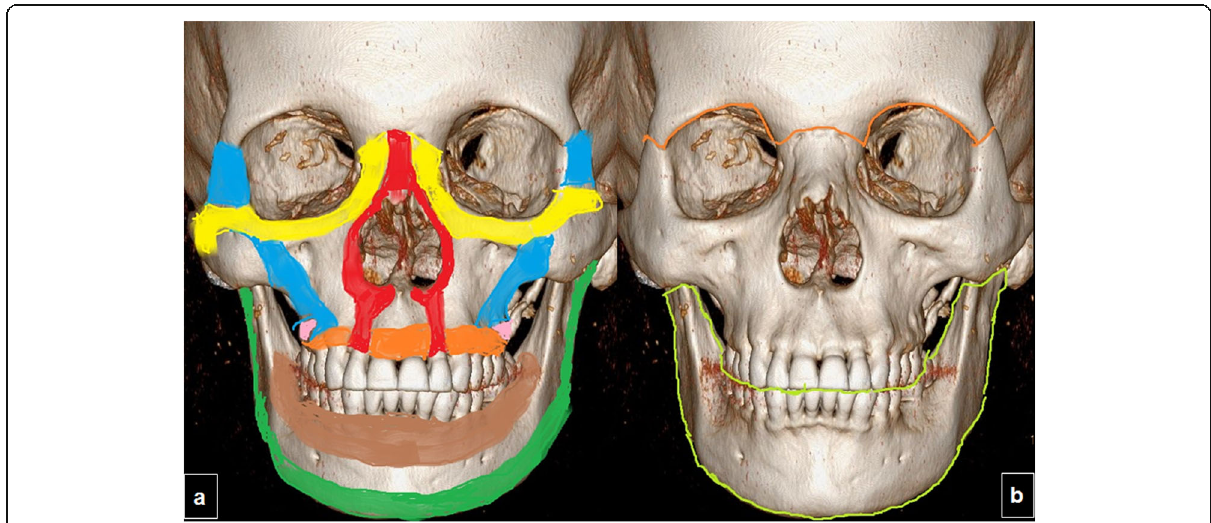
Fig. 1 Facial anatomy. a System of facial struts/buttresses. Three-dimensional CT images of an adult skull in frontal view with color overlays. The horizontal buttresses are the upper transverse maxillary (yellow), lower transverse maxillary (orange), upper transverse mandibular (brown), and lower transverse mandibular (green) buttresses. The vertical buttresses are the medial maxillary (red), lateral maxillary (blue), posterior maxillary (pink), and posterior mandibular (green) buttresses. b System of facial partitions. Three-dimensional CT image of an adult skull with color overlays shows partition of facial anatomy into upper (outlined in orange), middle, and lower (outlined in green) thirds, the system used by